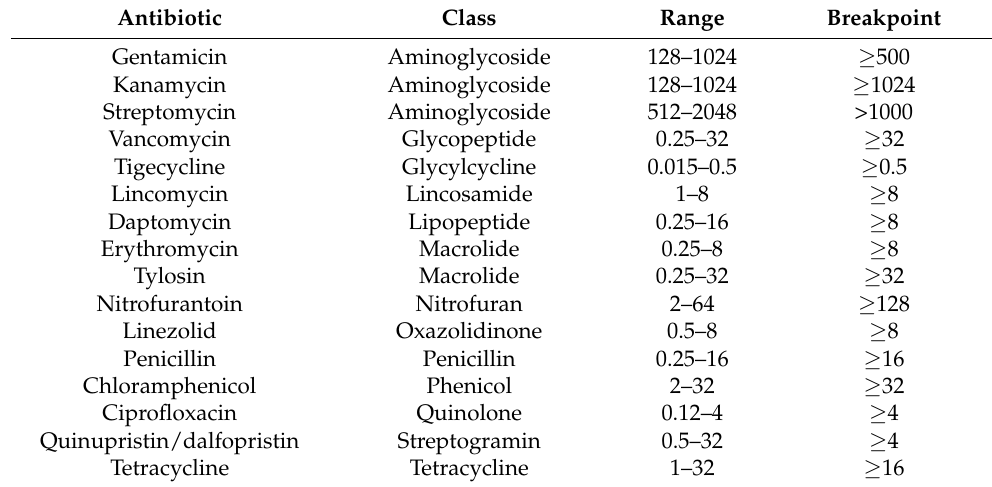
Table 1. Antibiotics ordered by class, concentration range (mg/L) and interpretive breakpoint (for resistance) for the NARMS (National Antimicrobial Resistance Monitoring System) Gram-positive plate (CMV3AGP), using CLSI (Clinical and Laboratory Standards Institute) criteria and NARMS interpretive human breakpoints when a CLSI equivalent was